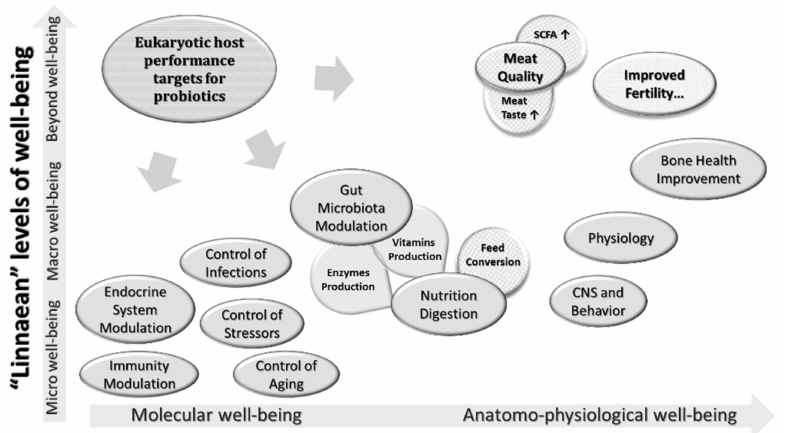
Figure 1. Pseudo-Linnaean representation of spore-forming effects on the poultry industry from the molecular and species levels to full-scale